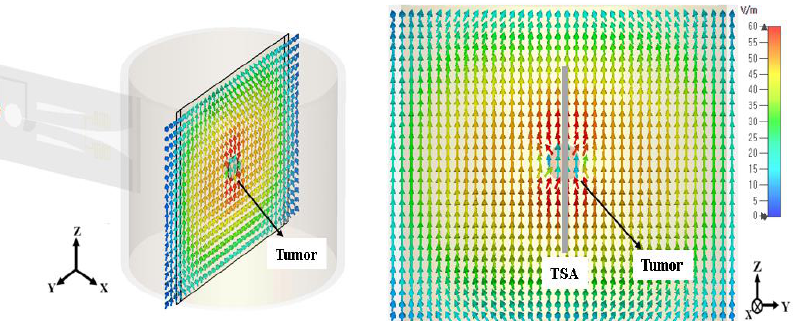
Figure 2. The simulated and measured reflection coefficients for the used TSA antenna.